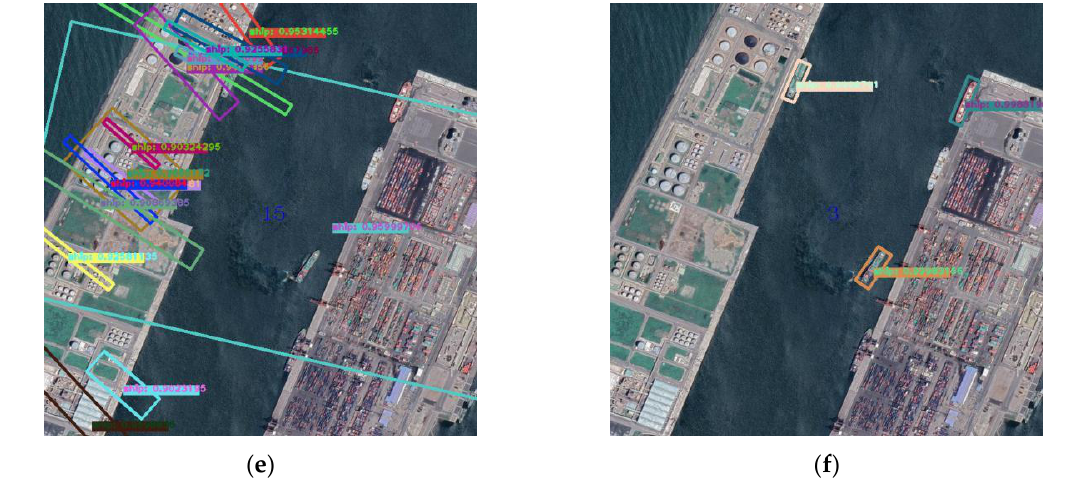
Figure 8. ( a , c , e ) are some of the results from the pre-trained model. ( b , d , f ) are some of the results from Figure 8. ( a ), ( c ), and ( e ) are some of the results from the pre-trained model. ( b ), ( d ), and ( f ) are some the model that was trained with the 50 simulation of the results from the model that was trained with the 50 simulation images.